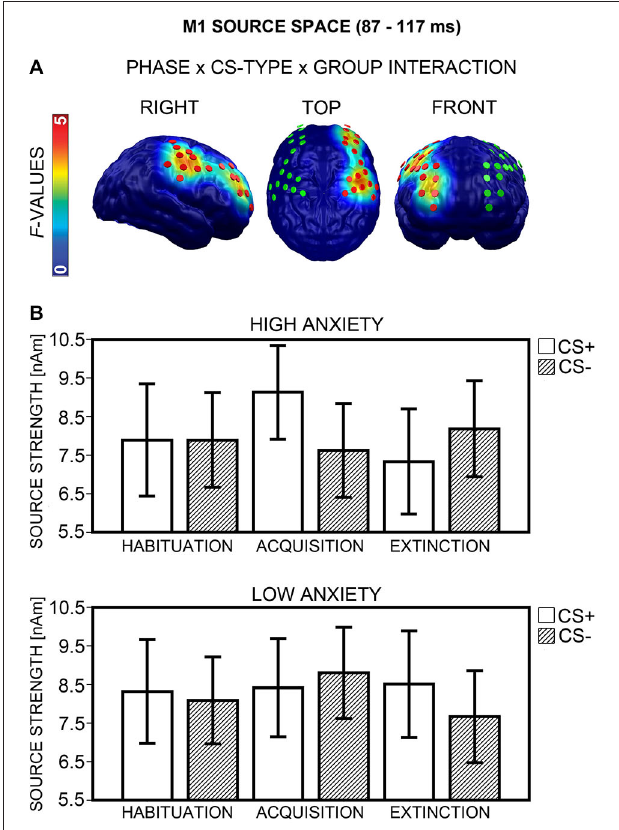
FIGURE 8 | Visualization of the M1 source space effect (87–117 ms) . (A) F -values for the Phase × CS-Type × Group interaction calculated for the M1 time-interval are projected onto standard brains, displayed from right, top, and frontal view. Red disks visualize the dipole locations used for post hoc statistical analyses, while green disks visualize the dipole locations of the mirror-symmetric left-hemispheric cluster. (B) Mean source strengths (95% confidence intervals) are shown for paired (CS+; white bars) and unpaired (CS − ; striped bars) stimuli for the high and low anxiety groups and the three conditioning phases.